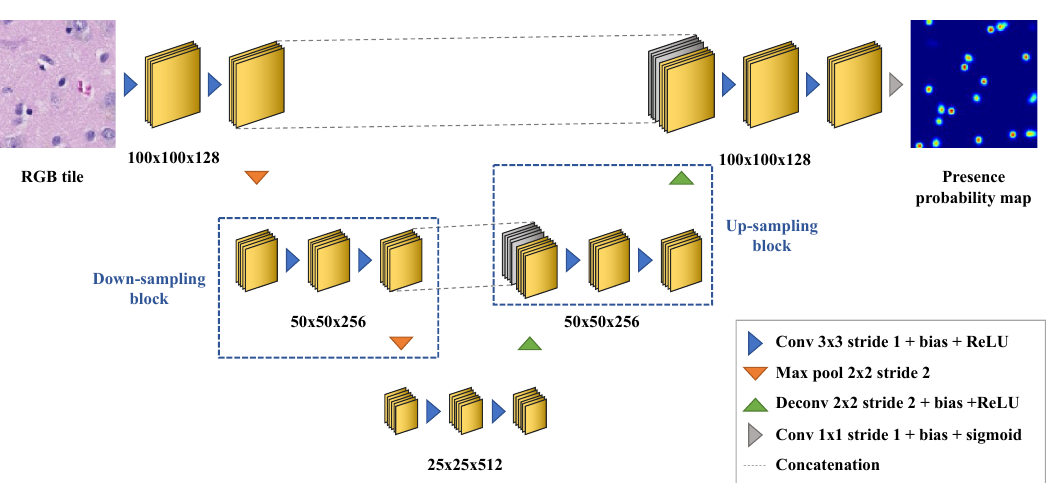
Figure A2. U-Net architecture with its feature map dimensions used for nuclei detection. The network takes 100px × 100px RGB tiles with pixel size 1µm × 1µm as input and predicts a nuclei presence probability map with the same spatial